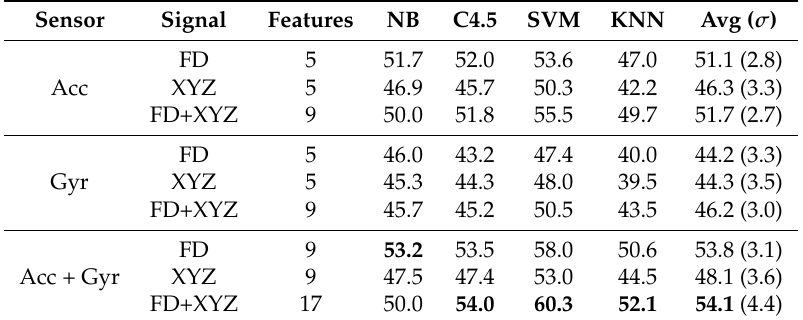
Table 3. Correctly classified instances (%) using sampled data, number of instances = 4400. Sensor Signal Features